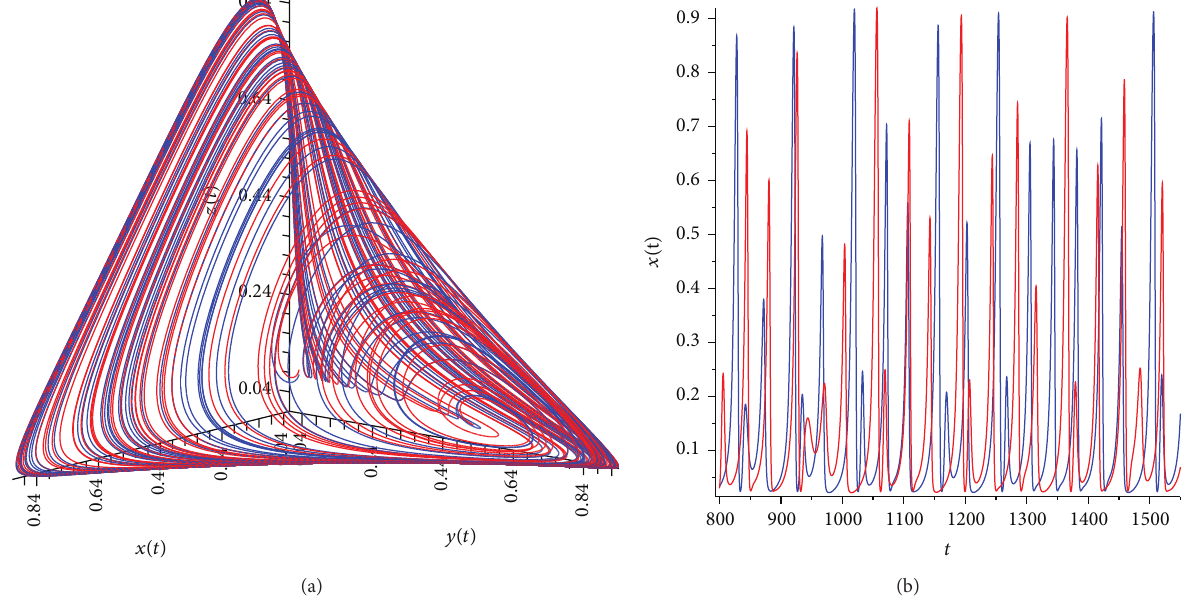
Figure 6: Chaotic attractor created through the period-doubling bifurcations. Initial conditions: (0.1325, 0.6687, 0.19) , (0.13, 0.6, 0.2) . (a) Chaotic attractor of system (1), with 𝑎 = 0.99 . Integration time: [0,1850] . (b) Sensitive dependence on initial conditions. Two solutions very close diverge exponentially in time, for 𝑎 = 0.99 . Integration time: [800, 1550]